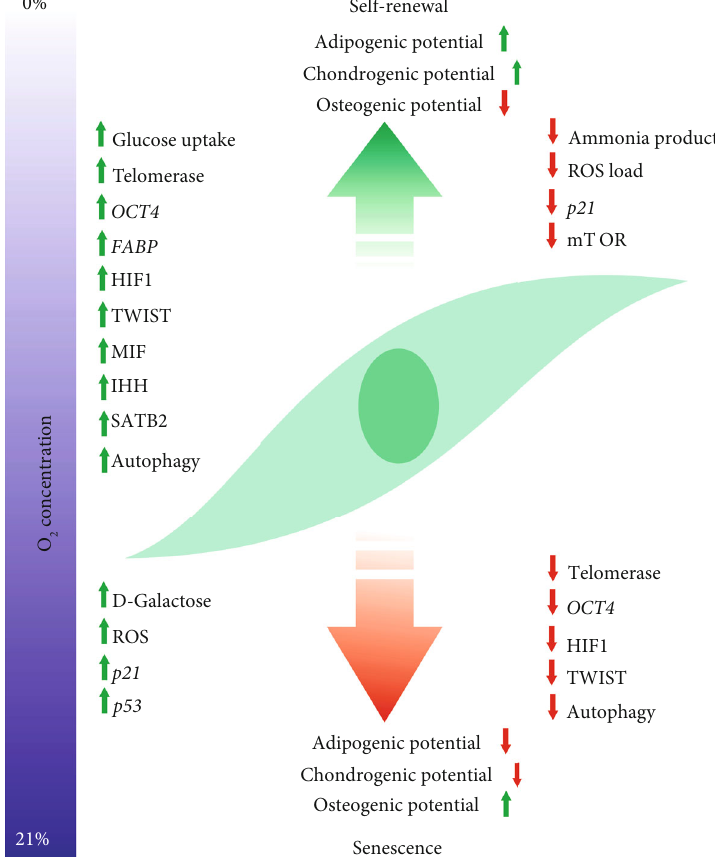
Figure 1: Schematic overview of the e ff ects of hypoxia on BMSC senescence. Oxygen depletion induces or activates a number of cellular processes that delay or reverse cellular senescence in BMSCs. These include induction of stem cell-speci fi c genes, upregulation of the HIF pathway and its e ff ectors, or activation of autophagy. Parallel, hypoxia represses prosenescence factors like production of reactive oxygen species or expression of genes involved in cell cycle arrest and reduce activity of signaling cascades like the mTOR pathway. Abbreviations used are OCT4: octamer-binding protein 4; FABP3: fatty acid binding protein 3; TWIST: basic helix-loop-helix transcription factor; HIF1: hypoxia-inducible factor 1; IHH: Indian Hedgehog protein; MIF: macrophage inhibitory factor; SATB2: special AT-rich binding protein 2; mTOR: mammalian target of rapamycin; ROS: reactive oxygen species. Table 1: Summary of studies investigating the e ff ects of hypoxia on BMSC senescence. Study fi